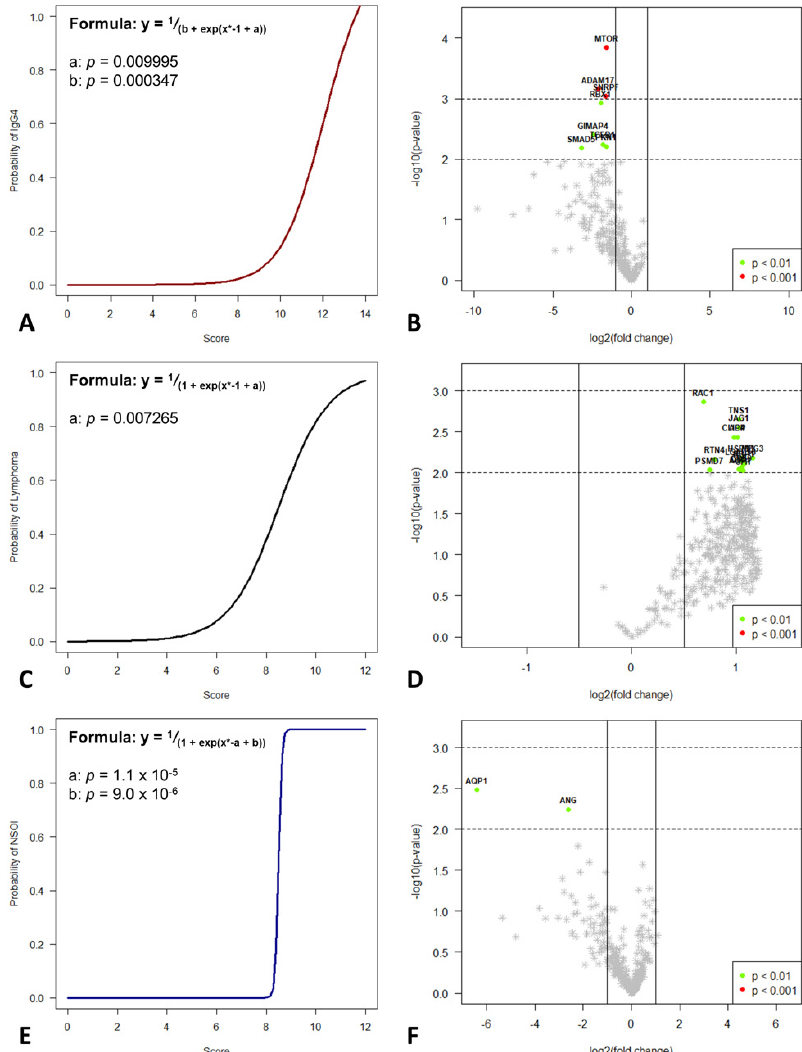
Figure 4. Decision-tree-based analysis using the “conditional inference tree” (CIT) machine learning algorithm revealed significant differences between the three groups. Based on these differently up- and downregulated genes, a logistic regression model was used to differentiate IgG4-ROD ( A ), MALT lymphoma ( C ), and NSOI ( D ) with a high probability. Volcano plots for IgG4-ROD ( B ), MALT lymphoma ( E ), and NSOI ( F ) shows the most significantly differentially expressed